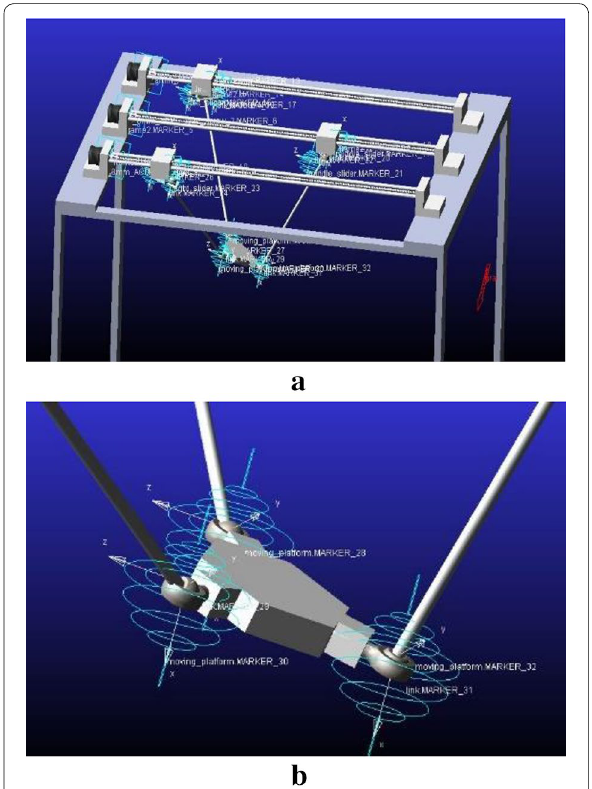
Figure 16 a Imported 3-PRUS mechanism in ADAMS, b Spherical joints assigned on the mobile platform in